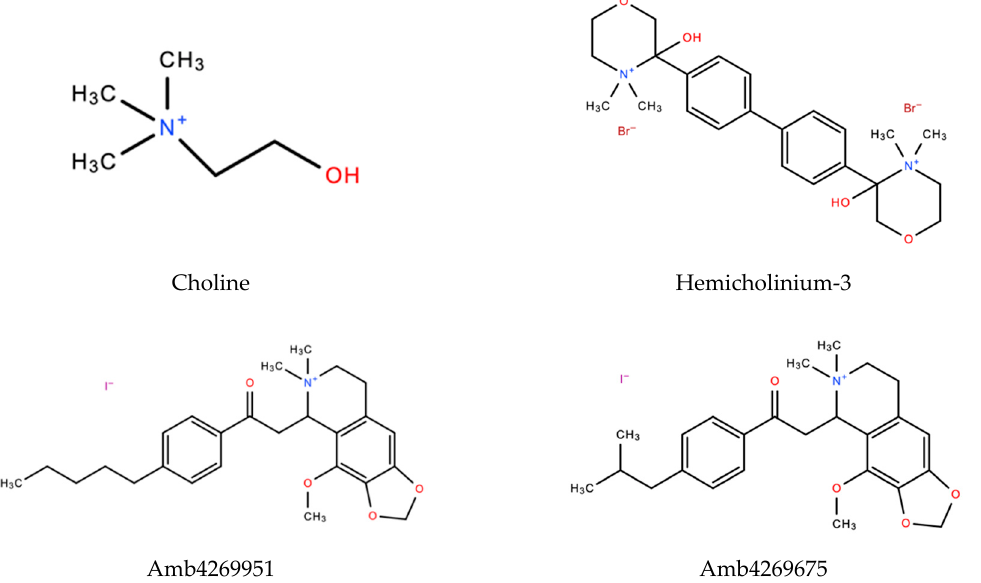
Figure 5. Chemical structure of choline (2-hydroxyethyl(trimethyl)ammonium), hemicholinium-3 (2,2 ′ -(4,4 ′ -biphenylene)bis(2-hydroxy-4,4-dimethylmorpholinium